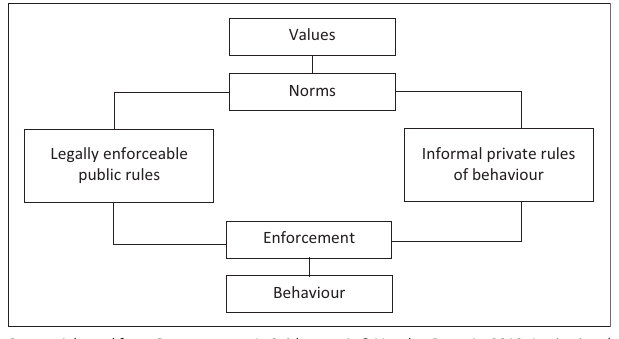
FIGURE 1: Institutions, law enforcement and